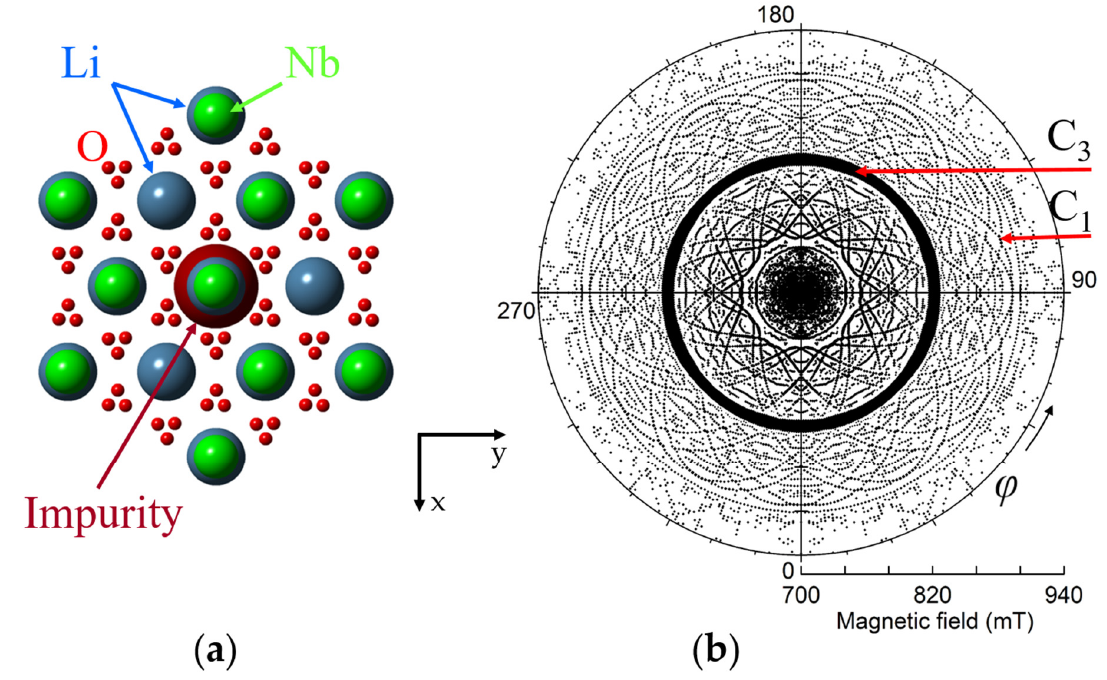
Figure 3. ( a ) Projection of ideal lithium niobate lattice with Nd 3+ impurity ion on xy plane (artificial sizes of balls are used). ( b ) Circular diagram of measured angular dependence of electron paramagnetic resonance (EPR) lines of Nd 3+ ions in Figure 3. Magnetic field was rotated in xy plane from 0 to 360 deg. ν = 34.445 GHz, T = 19 K. Symbol sizes reflect line intensities.